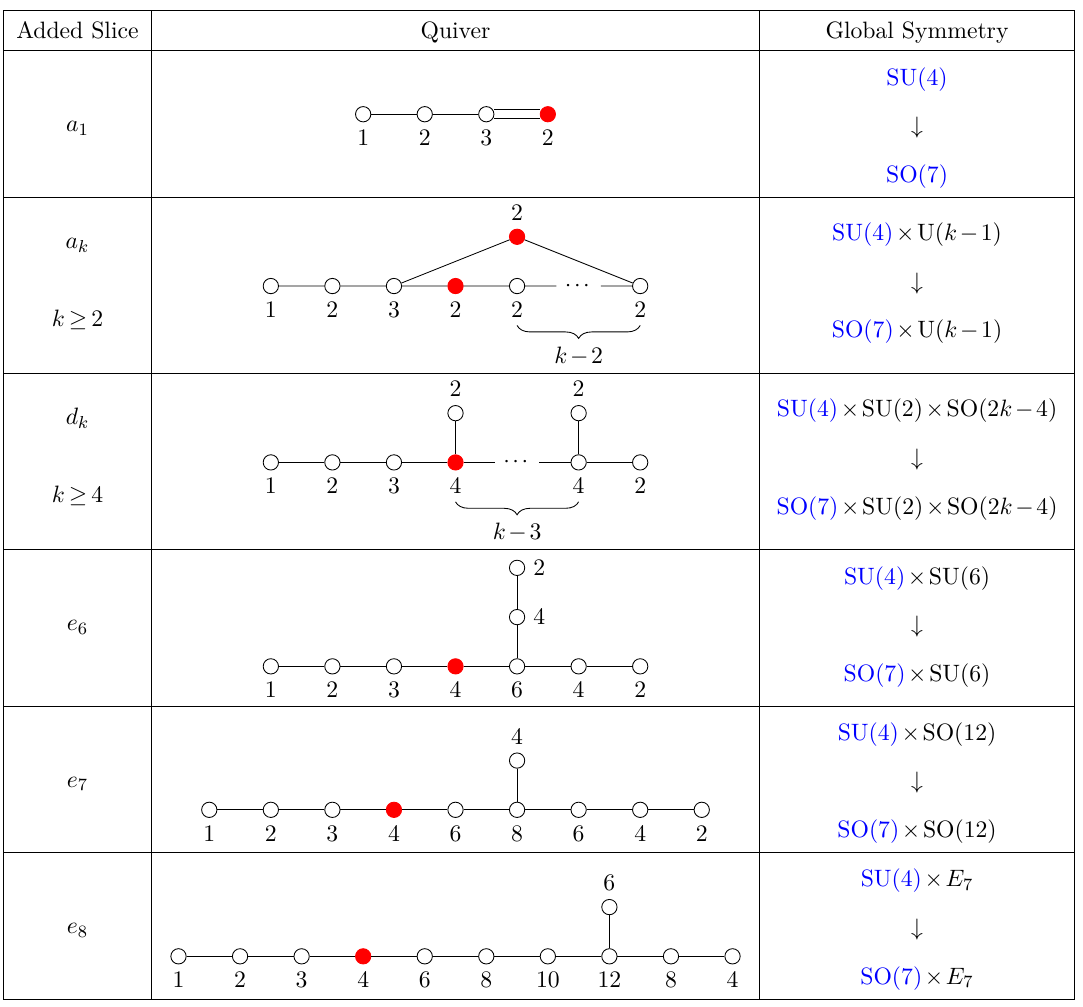
Table 5 . Quivers resulting from adding the possible simply laced elementary slices to n.min B 3 (4.5) to absorb a